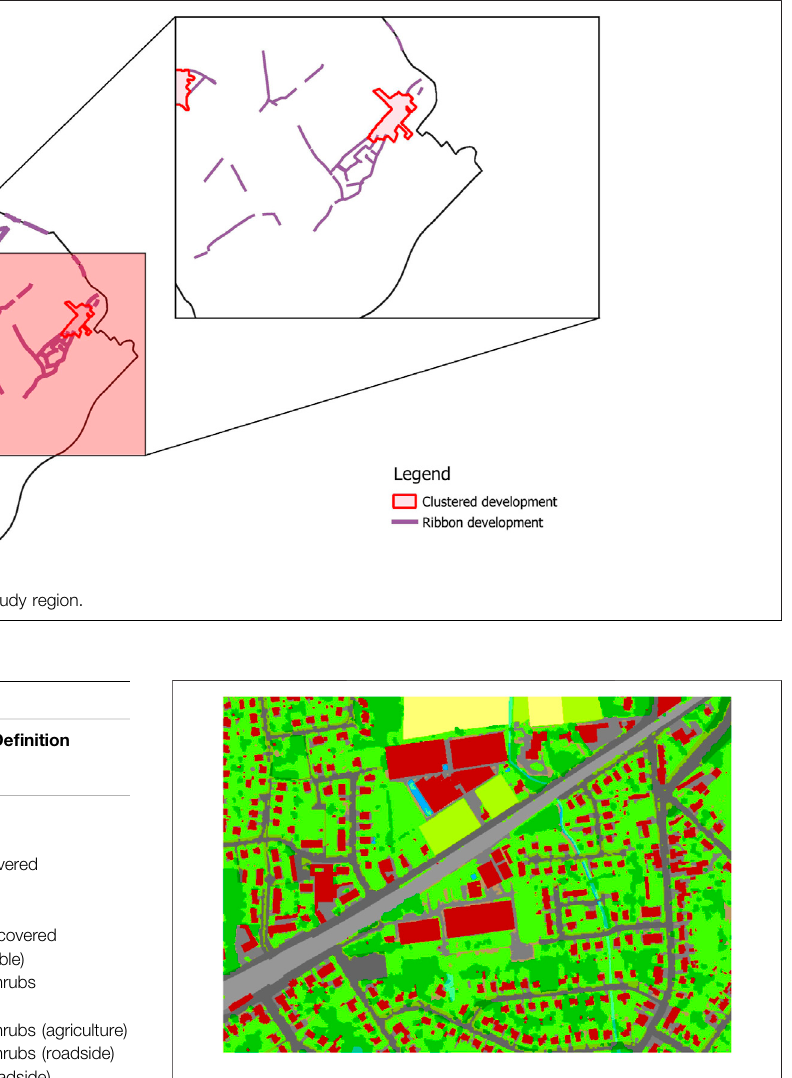
FIGURE 7 | Zoomed in snippet of the ground cover, clearly displaying overlapping colours (area = 0.427 km 2